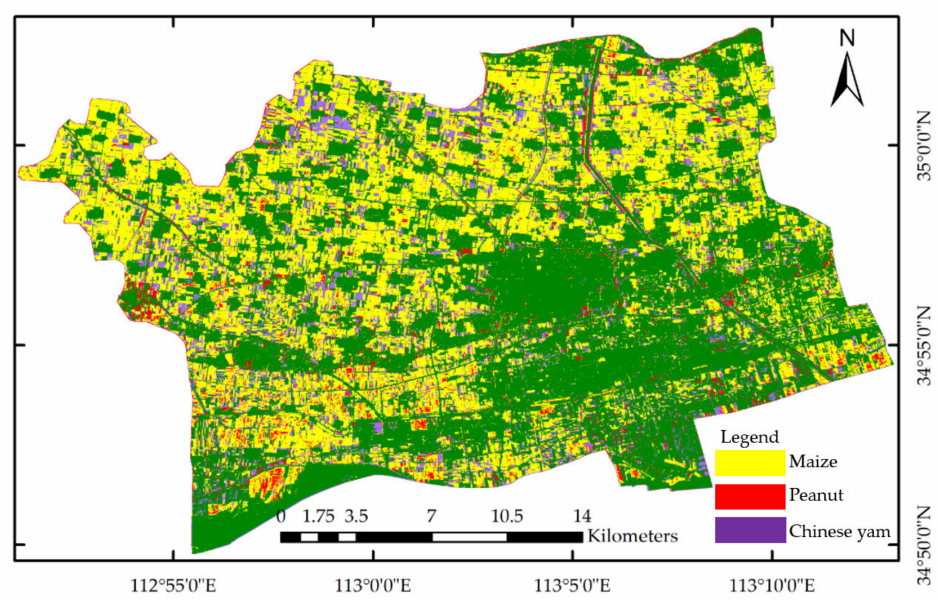
Figure 9. Crop classification map produced by fusion of multi-temporal Sentinel-1 and -2 data.